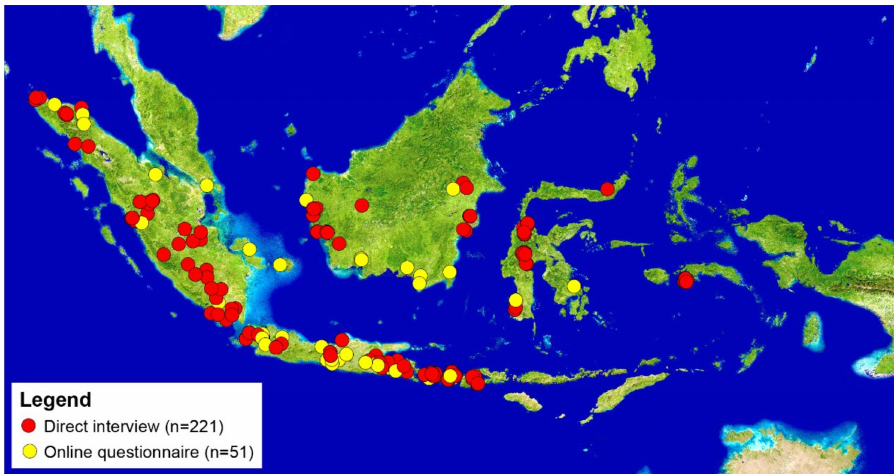
Figure 1. Map of research survey of beekeepers in